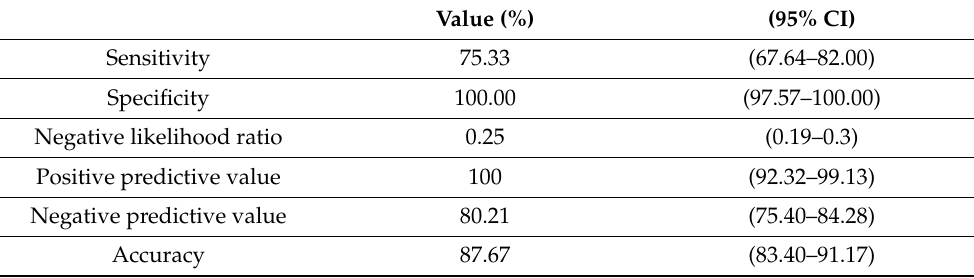
Figure 2. Linear regression of RT-qPCR Ct values versus the level of antigen (log10 transformed TCID50/mL results) obtained on the DiaSorin LIAISON SARS-CoV-2 Ag assay.